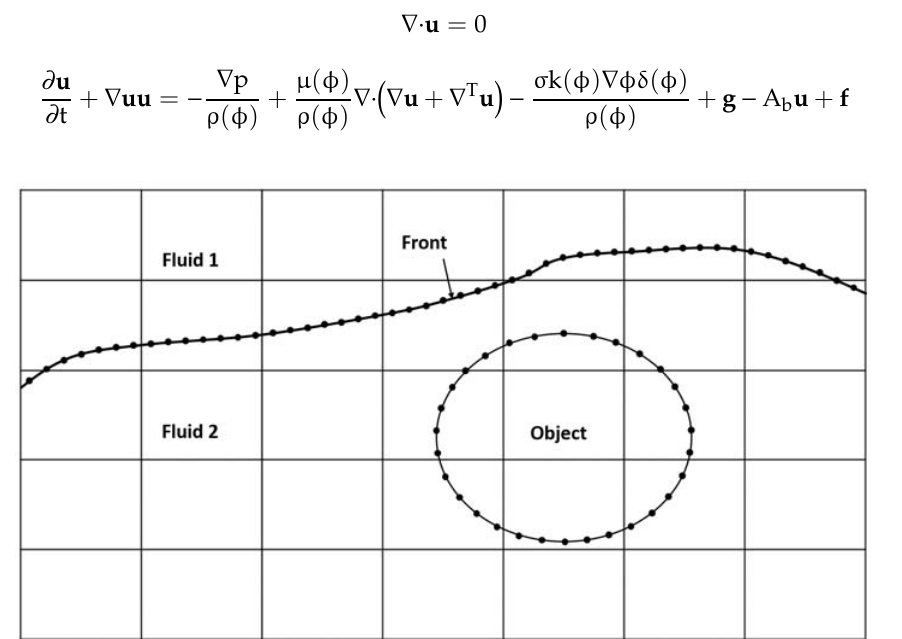
Figure 1. Computations of flow containing two ‐ phase, including immersed boundary. The governing equations are solved on a fixed grid, but the interface between two fluids is represented by a moving front in which it is consisting of connected marker points, and the immersed object is included in the governing equation by the immersed boundary method.